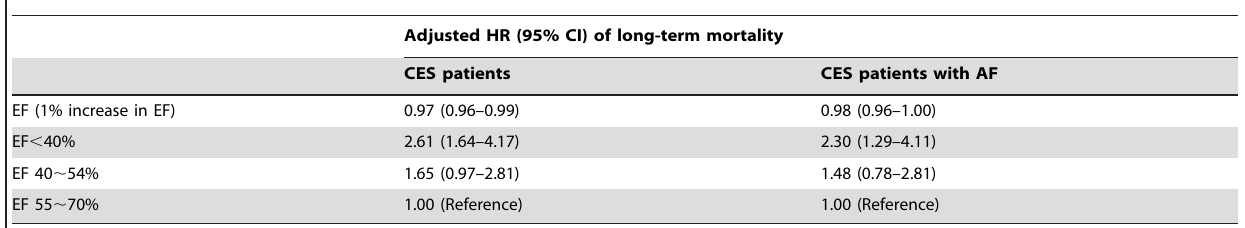
Table 3. Multivariable model hazard ratios for long-term outcomes by EF compared with normal values.